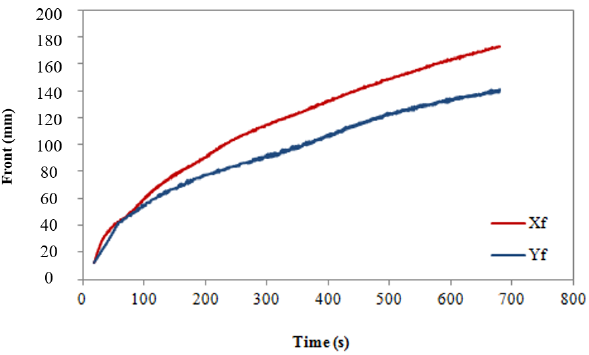
Figure 7: Flow front versus time for 200 gsm woven fabric